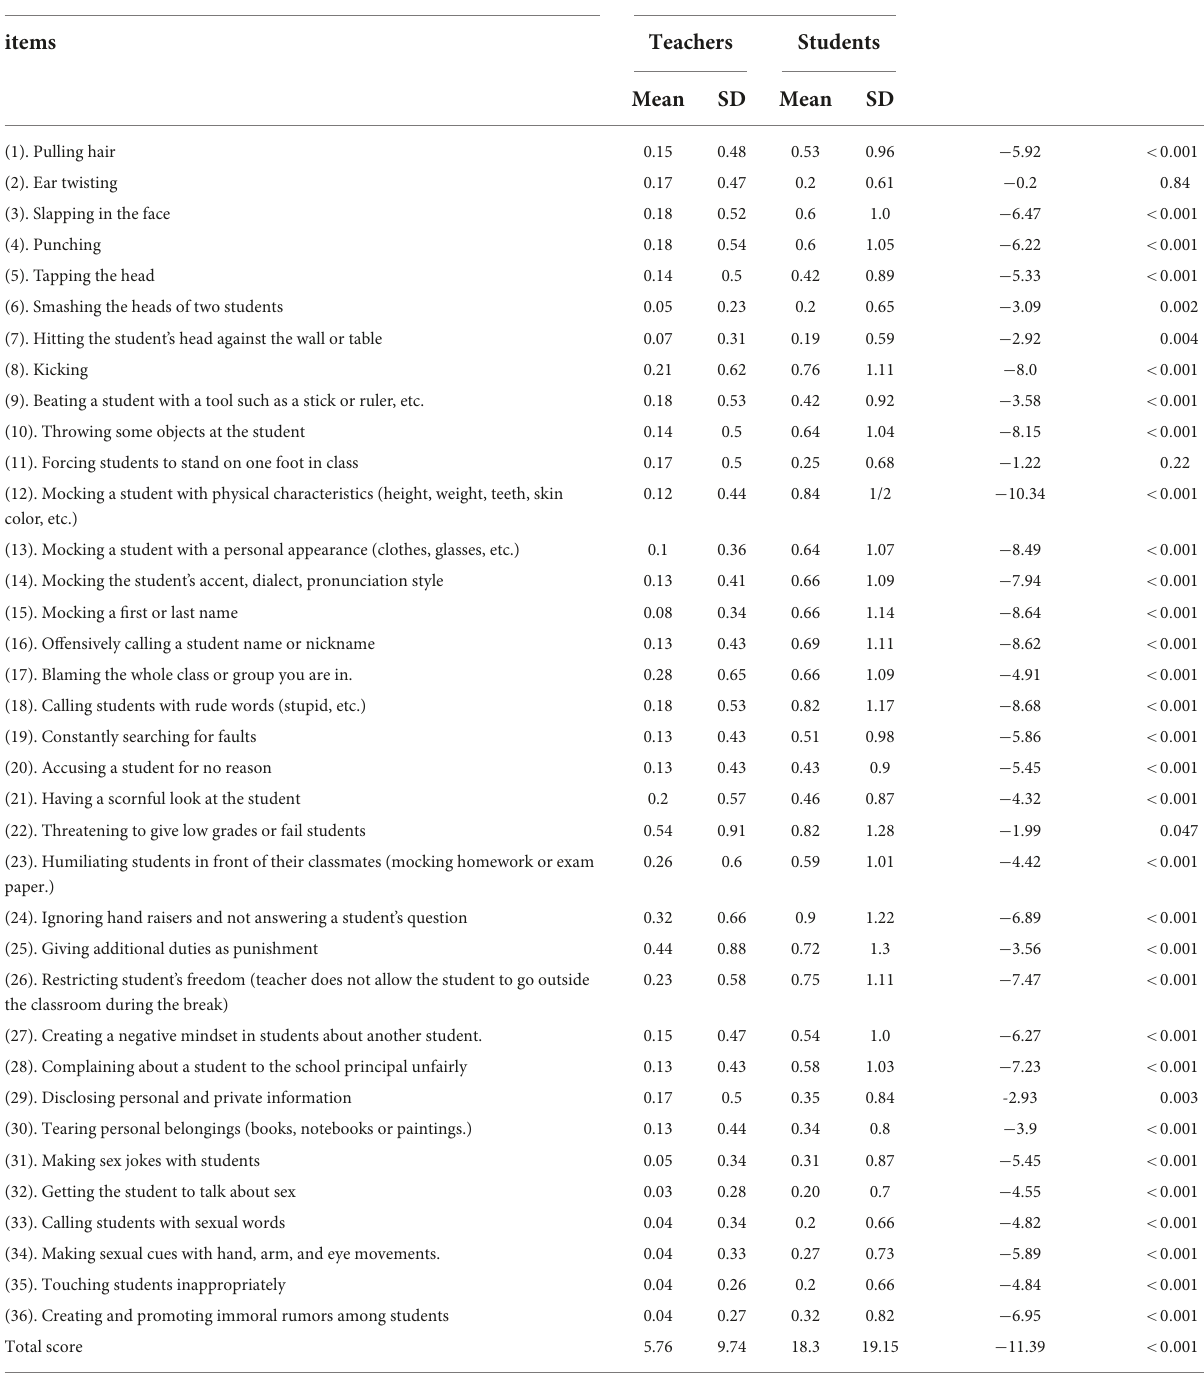
TABLE 3 Comparison of teacher violence from the perspectives of teachers and students. Group Teacher violence Mann-Whitney test